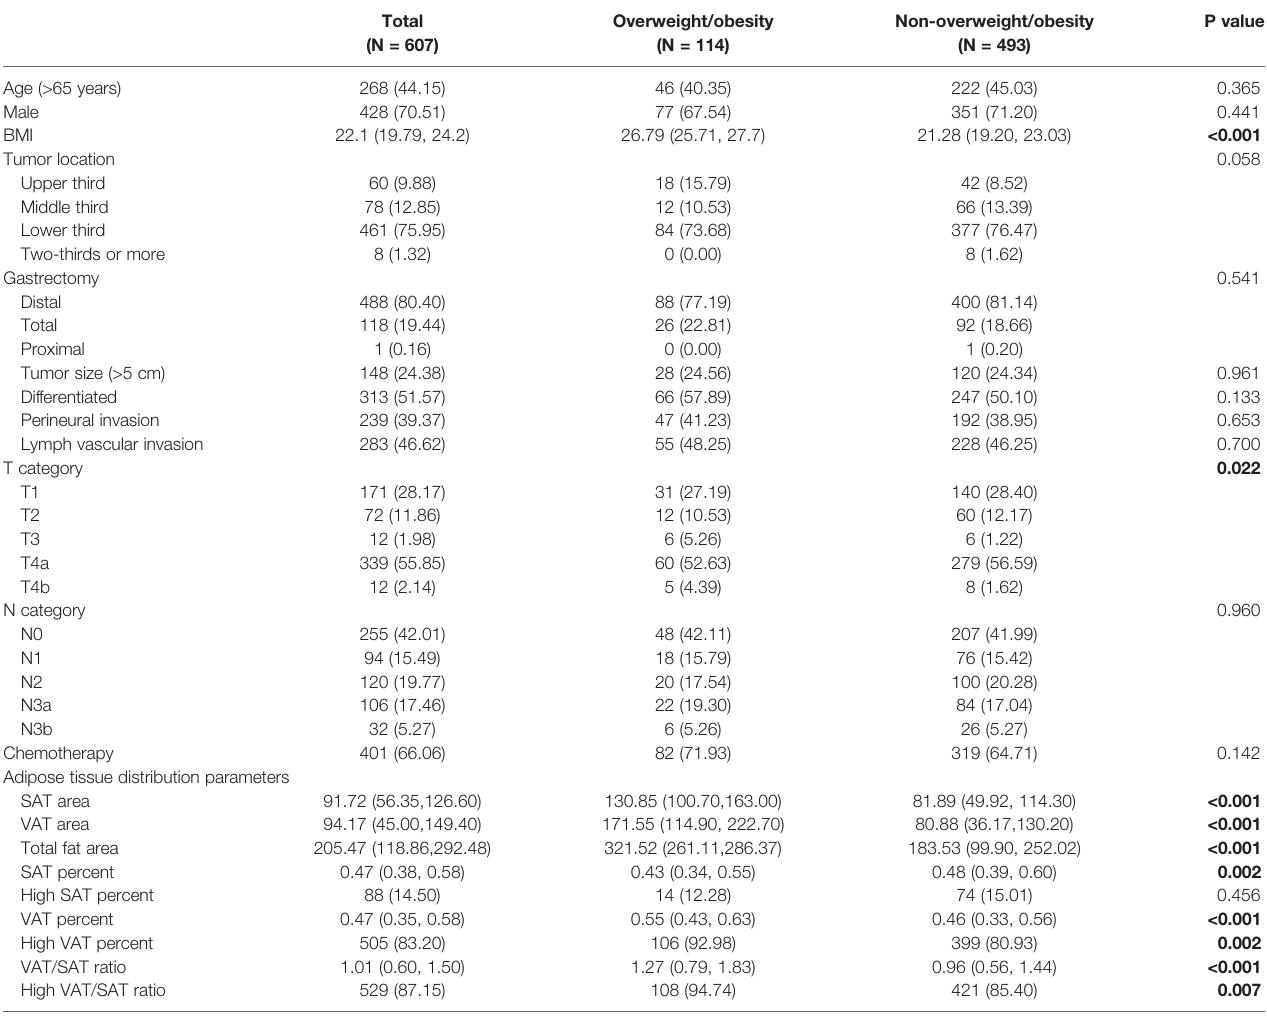
BMI, body mass index; SAT, subcutaneous adipose tissue; VAT, visceral adipose tissue. P value for difference between groups in percentages (chi-square test or Fisher ’ s exact test) or rank sum (Kruskal – Wallis test). Bold values represent statistically signi fi cant differences (P <